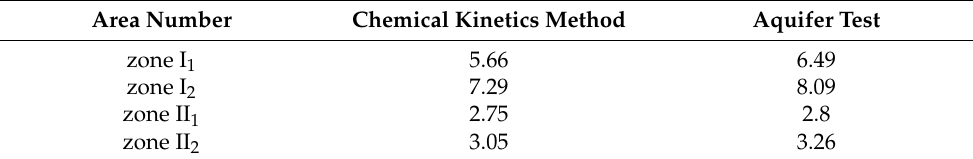
Table 3. Hydraulic conductivity calculated by the chemical kinetics method and the aquifer test ( m / d ).